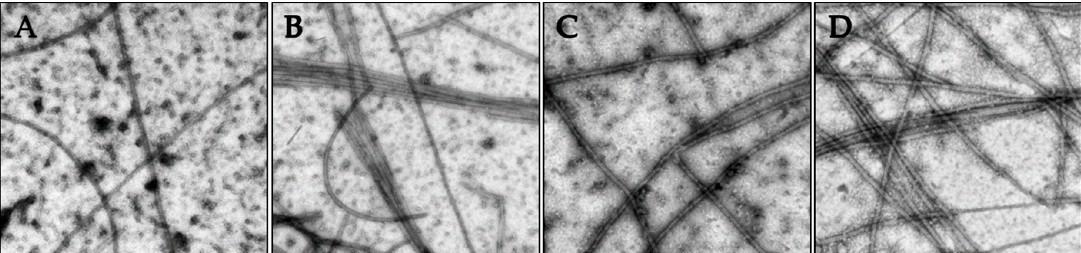
Figure 5. The effects of the Janus compounds on tubulin polymer were visualized by electron microscopy and images shown at 50,000× magnification: ( A ) vehicle control; ( B ) 10 μ M paclitaxel; ( C ) 50 μ M 2 ; and ( D ) 10 μ M 3 . The samples were fixed for microscopy following 35 min of polymerization.